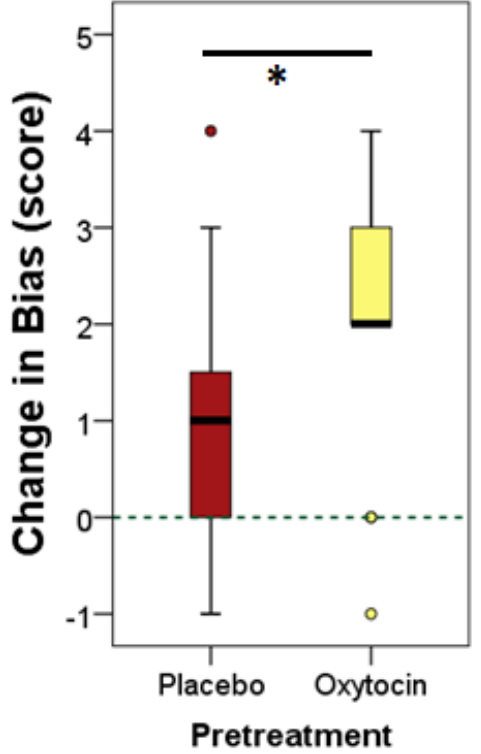
Figure 3. Change-in-bias scores of the oxytocin and placebo (isotonic sodium chloride) pre-treatment groups in Experiment II. Medians are represented by bold lines; boxes indicate the lower and upper interquartile range and whiskers extend to the smallest and largest values excluding outliers and extremities. Asterisk (*) indicates significant difference between dogs received intranasal oxytocin and placebo pre-treatment at p < 0.05.